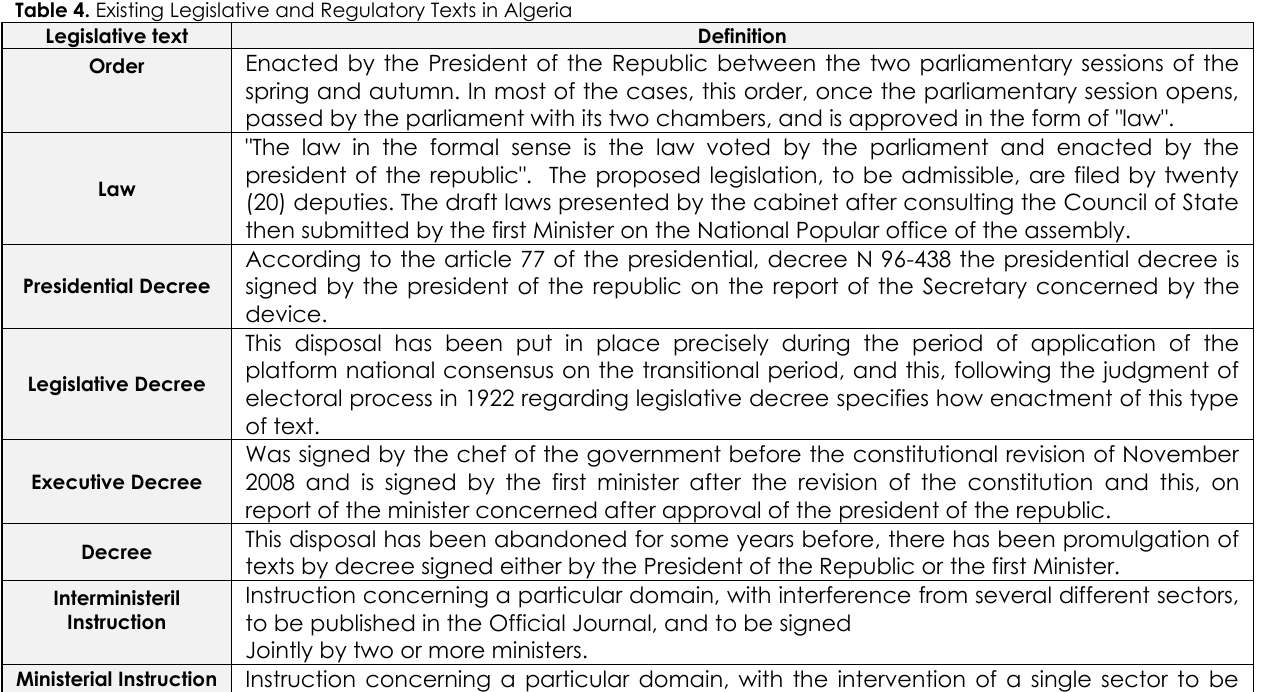
Table 4. Existing Legislative and Regulatory Texts in